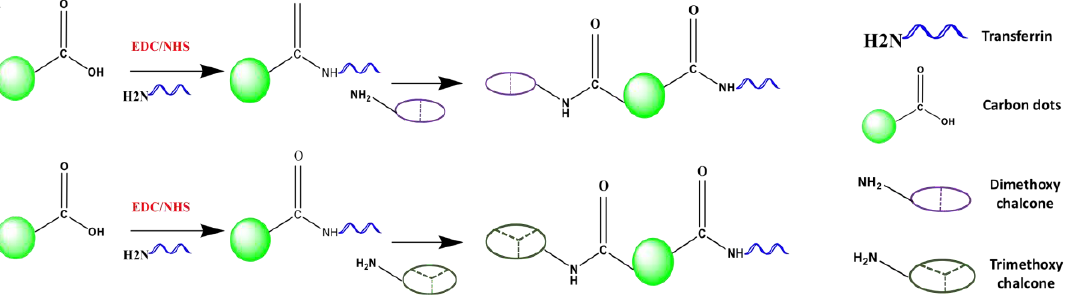
Figure 5. Schematic illustration of the synthesis of the C-dot-trans chalcone conjugates . Carboxyl groups are activated by EDC/NHS then reacted to the amino groups of transferrin and 4′ amino di- methoxy ( A ) or 4′ amino trimethoxy ( B ) chalcone. For simplicity only one molecule of transferrin and chalcone are shown. Not drawn to scale.